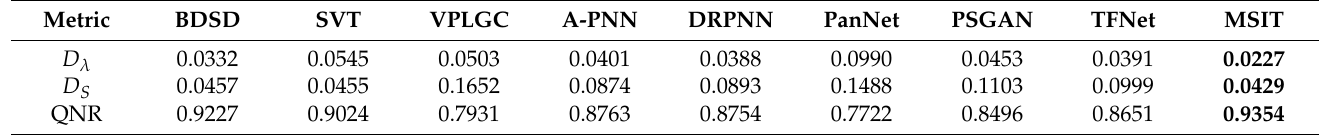
Table 5. Numerical evaluations of the fused images in Figure 8 (QuickBird dataset).